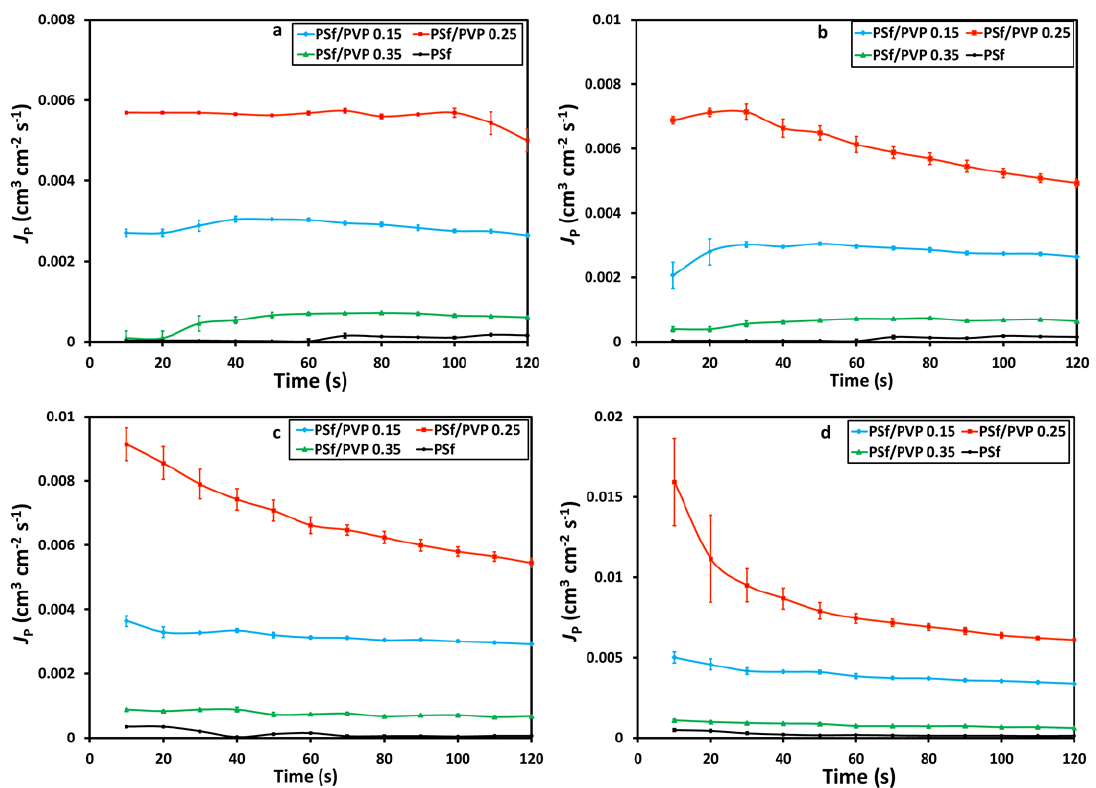
Figure 5. The profile of pure water flux (cm 3 ·cm −2 ·s −1 ), J P , with time at the feed pressure of ( a ) 4 bar, ( b ) 5 bar, ( c ) 6 bar, and ( d ) 7 bar on the membrane filtration process.